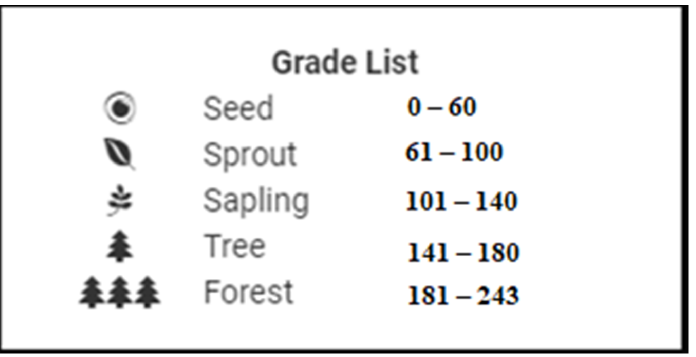
Figure 2. Kudos Grade List.